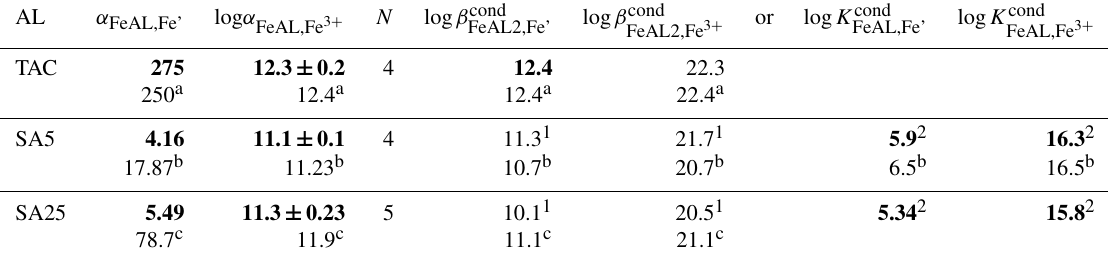
Table 1. Average beta and alpha values of the added ligands (AL) with the standard deviation around the mean of N experiments. In bold are the parameters used in this study to calculate the model ligand characteristics, 1: assuming one FeAL is formed, either FeSA or Fe(SA)2, 2: assuming both FeSA and Fe(SA)2 are formed. (a–c) indicate literature values: a Croot and Johanson (2000) using log α inorg = 10; b Abualhaija et al. (2015) using log α = 9 . 98; c Buck et al. (2007) using log α = 10. Alpha values of the AL are the direct outcomes inorg inorg of the calibration exercises; therefore, these have a standard deviation added, which is the standard deviation around the mean of four calibrations. Since K and/or β are directly derived by dividing through the AL concentration or squared concentration, the standard deviations of log K cond and log β cond have the same values. FeAL,Fe’ FeAL2,Fe’ N log β cond log β cond or log K cond log K cond AL α FeAL,Fe’ log α FeAL2,Fe’ FeAL,Fe’ FeAL,Fe 3 + FeAL2,Fe 3 + FeAL,Fe 3 + TAC 275 12.3 ± 0.2